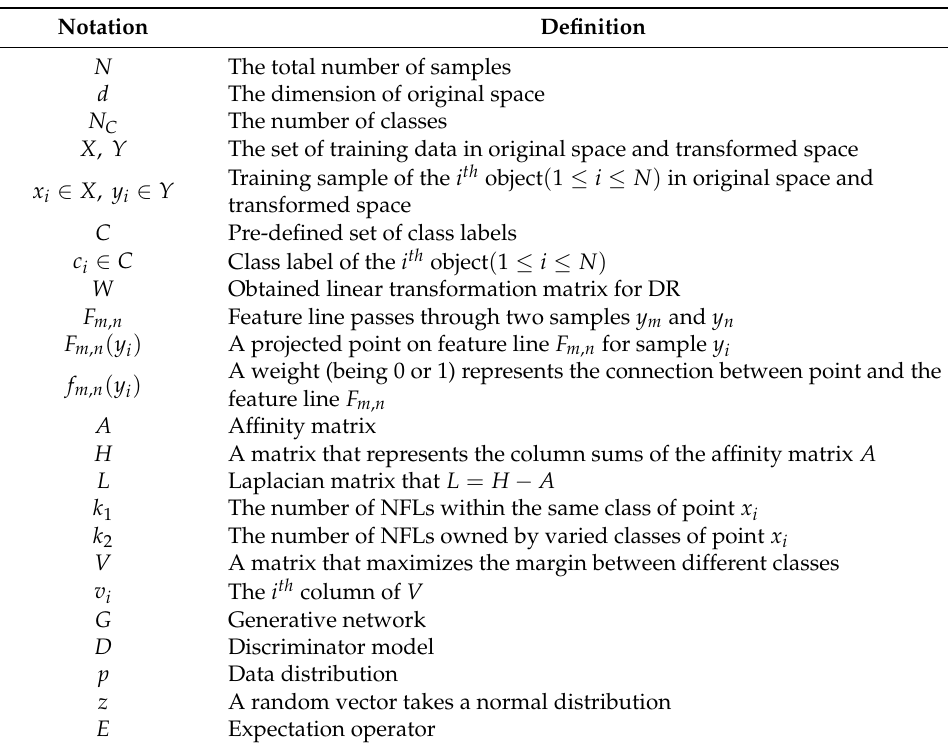
Table 1. List of